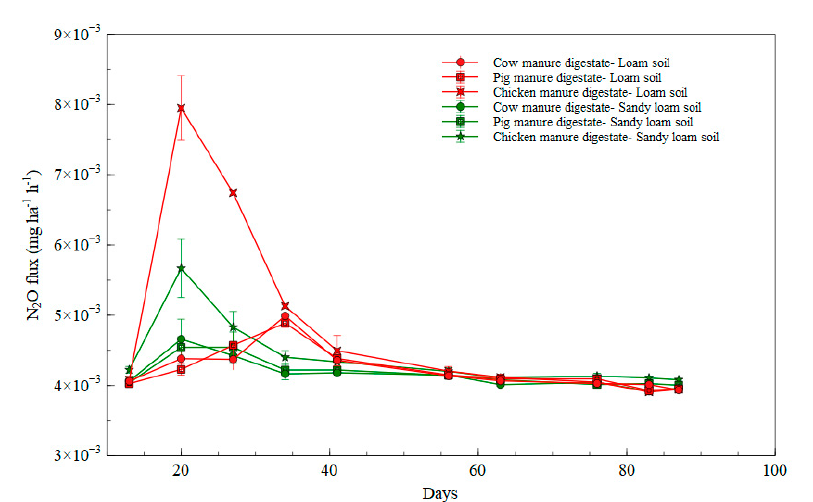
Figure 5. N 2 O emissions in digestate treatments in loam and sandy loam soil.